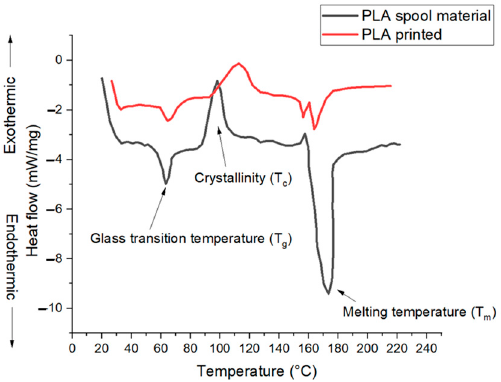
Figure 3. Comparison of differential scanning calorimetry (DSC) of PLA spool material and printed PLA.